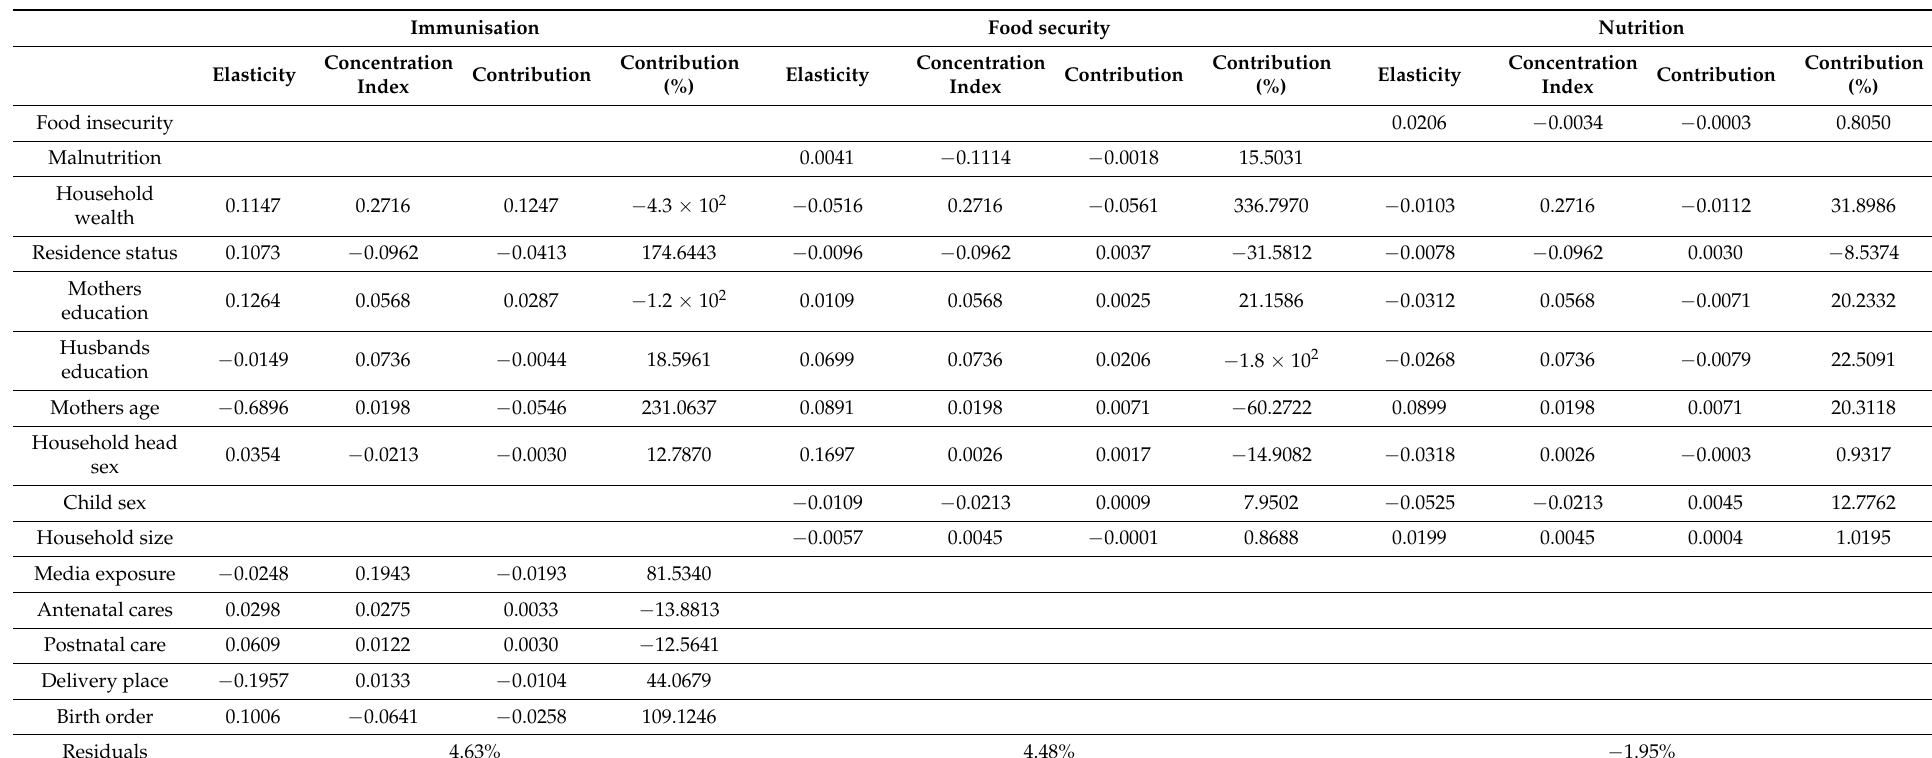
Table 6. Decomposition of child health indicators across child health determinants in South